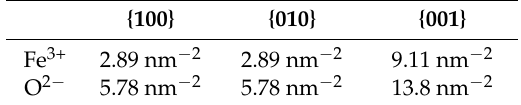
Table 2. Packing density of Fe 3+ and O 2 − for various facets of α -Fe 2 O 3 nanodiscs